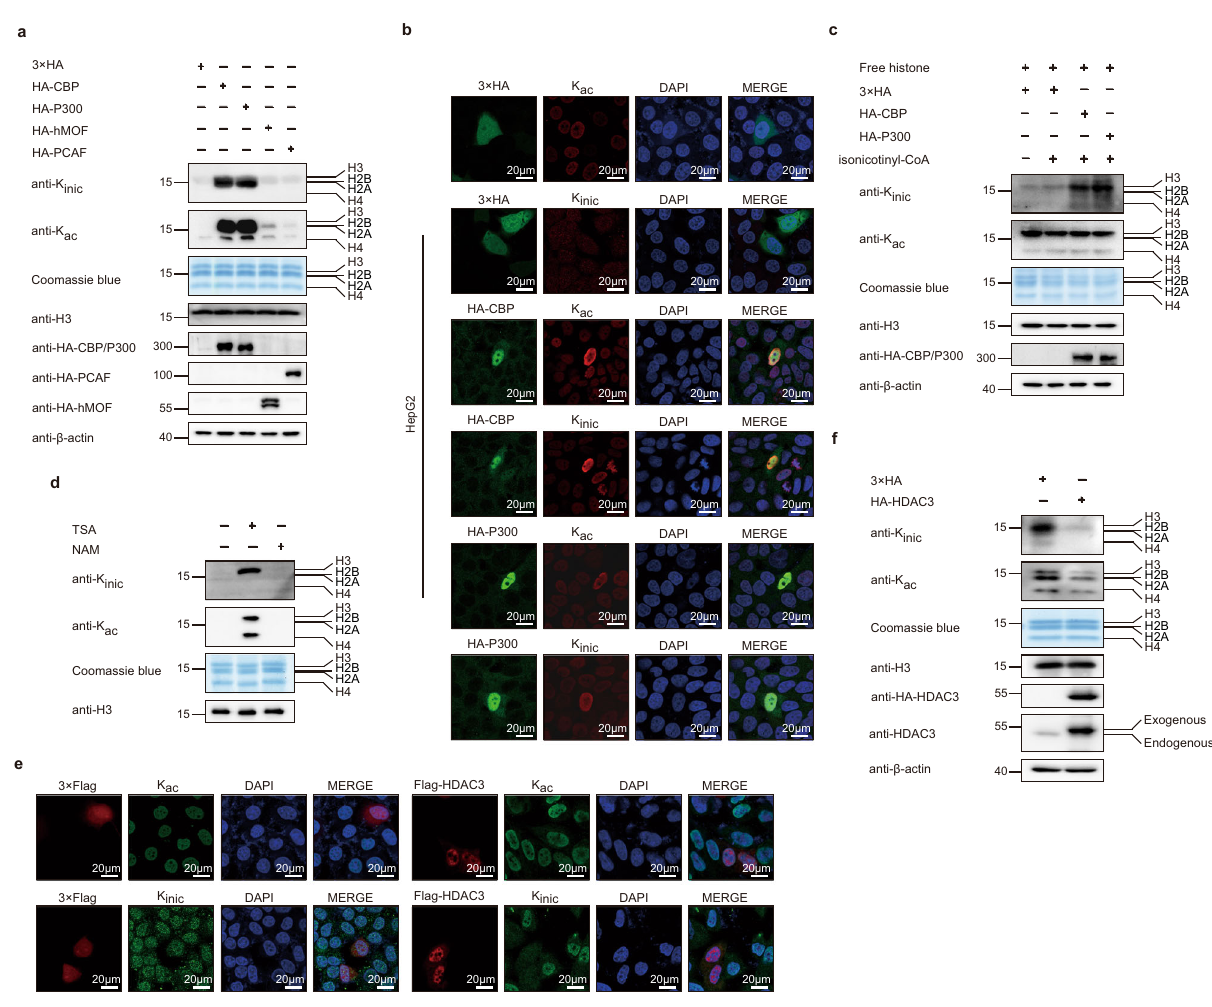
Fig. 4 CBP/P300 function as isonicotinyltransferases and HADC3 as deisonicotinylase for histone K inic . a – c CBP/P300 catalyze histone K inic in vivo and in vitro. a HepG2 cells were transfected with 3×HA, HA-CBP, HA-P300, HA-hMOF and HA-PCAF plasmids respectively, core histones acid-extracted and tested using pan-K inic , pan-K ac and H3 antibodies. Total histones were visualized with Coomassie blue staining. And total proteins were extracted and tested using HA-tag and β -actin antibodies by Western blot analysis. b HepG2 cells were transfected with 3×HA, HA-CBP, or HA-P300 and stained with pan-K ac or pan- K inic rabbit (red) and HA-tag mouse (green) antibodies. Nuclei were stained with DAPI (blue), followed by visualization with confocal microscopy. Scale bar, 20 μ m. c HA-CBP and HA-P300 plasmids were transfected into HEK293T cells, then the protein was puri fi ed with HA beads and subjected to in vitro isoniconitylation assay with or without Inic-CoA using free core histones from HepG2 cells as substrates. Tested using pan-K inic , pan- K ac , and H3 antibodies. Total histones were visualized with Coomassie blue staining. And total proteins were extracted and tested using HA-tag and β -actin antibodies by Western blot analysis. d – f HDAC3 removes histone K inic. d Core histones acid-extracted from HepG2 cells that treated with 3 μ M TSA (Trichostatin A) or 5 mM NAM (Nicotinamide) for 12 h and tested using pan-K inic , pan-K ac , and H3 antibodies by Western blot. Total histones were visualized with Coomassie blue staining. e HepG2 cells were transfected with 3×Flag or Flag-HDAC3 plasmid and stained with pan-K ac or pan-K inic rabbit (green) and Flag-tag mouse (red) antibodies. Nuclei were stained with DAPI (blue), followed by visualization with confocal microscopy. Scale bar, 20 μ m. f HepG2 cells were transfected with 3×HA, HA-HDAC3 plasmids, core histones acid-extracted and tested using pan-K inic , pan-K ac , and H3 antibodies. Total histones were visualized with Coomassie blue staining. Total proteins were extracted and tested using HA-tag, HDAC3, and β -actin antibodies by Western blot